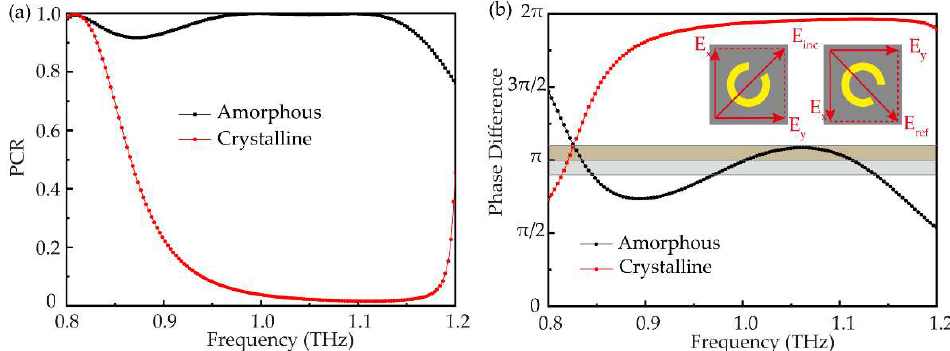
Figure 4. ( a ) The PCR with respect to the frequency in two states. ( b ) The calculated phase difference between the two orthogonal polarizations in two states (the dark yellow and grey band represent the slight variation of phase difference of π).